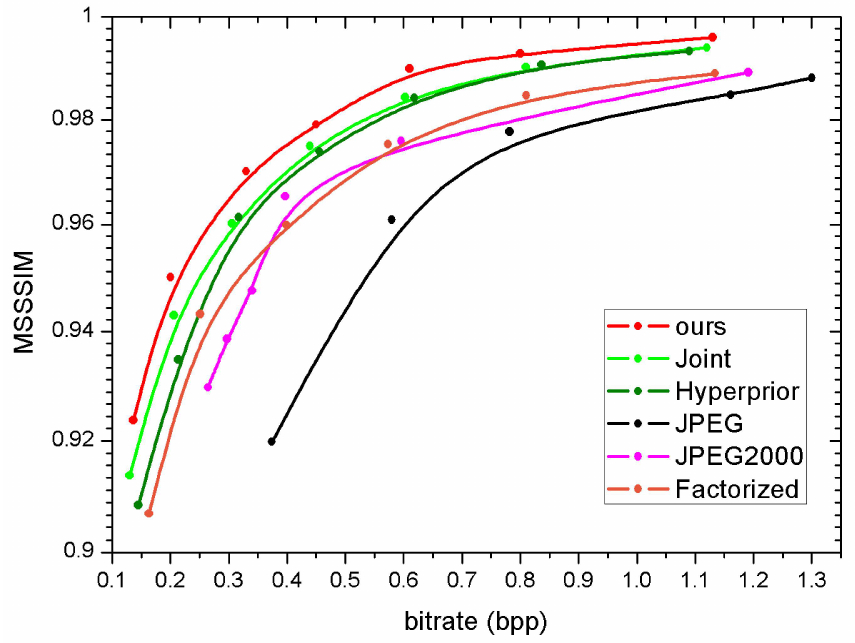
Figure 8. The rate-distortion compression performance of the proposed algorithm and comparison algorithms. The rate is measured by bit per pixel (bpp) and distortion is measured by